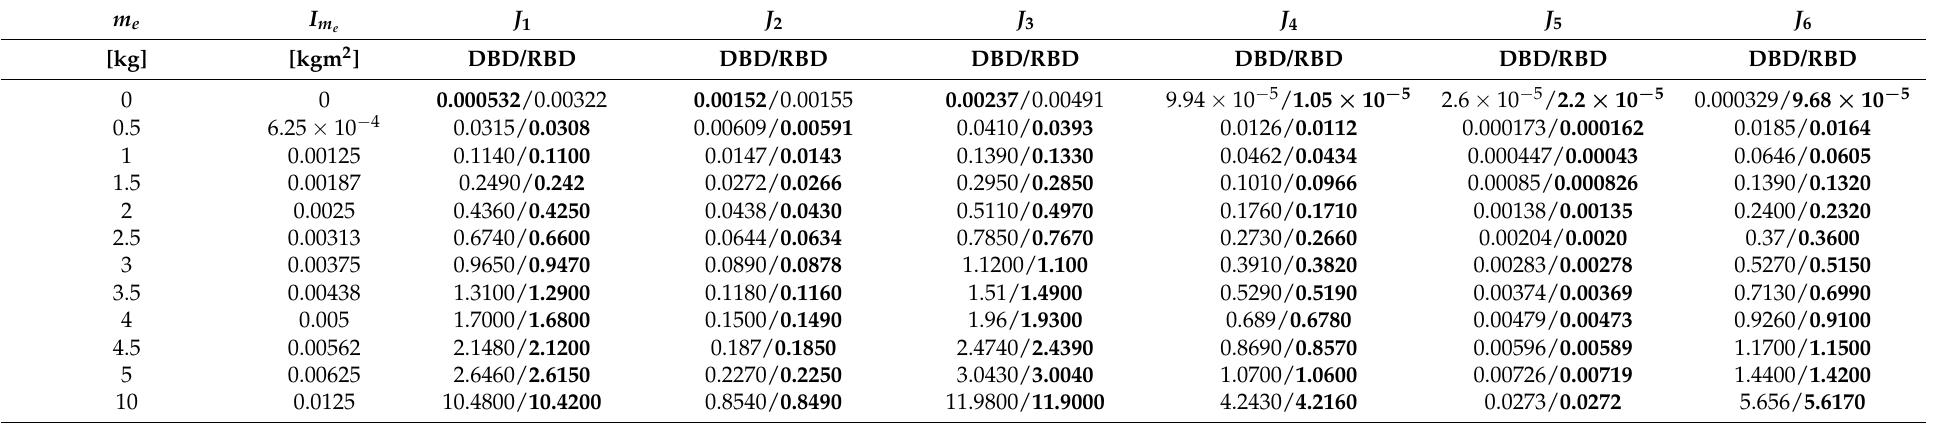
Table 6. Performance functions of the RBD and the DBD under the effect of mass variations.